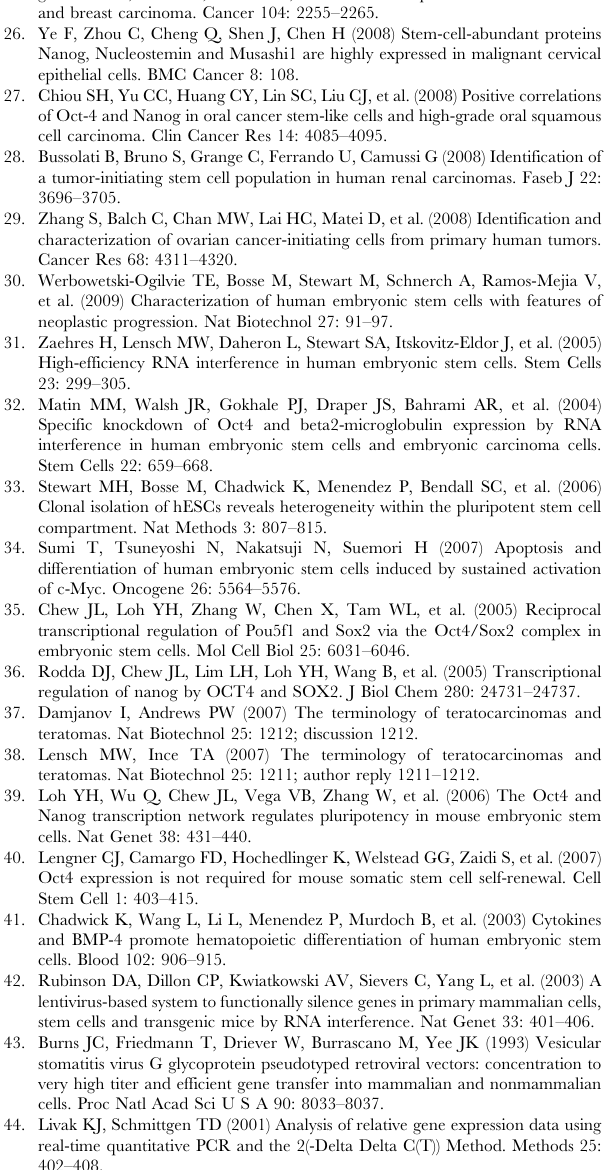
Table S2 Primers used in quantitative real-time reverse transcription-polymerase chain reaction